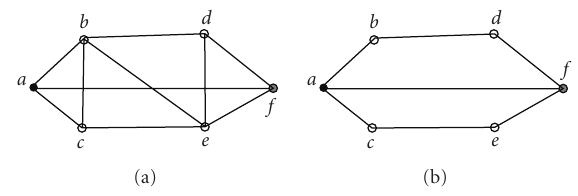
Figure 5: Constraint edge af is added to PLDel.